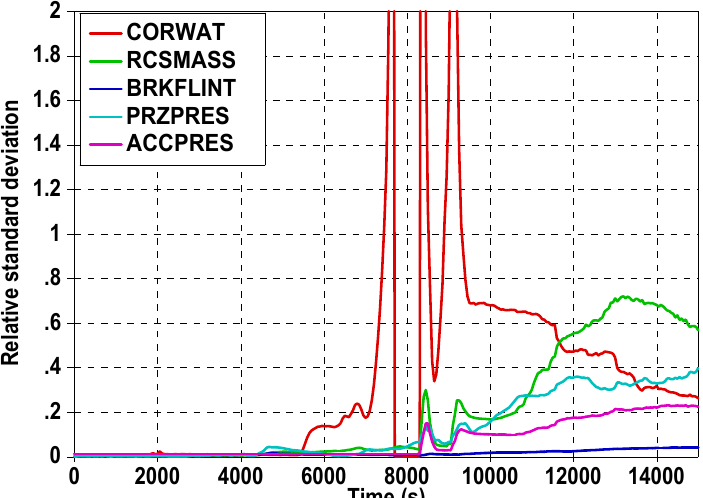
Figure 10. Relative standard deviations for thermal hydraulic variables.